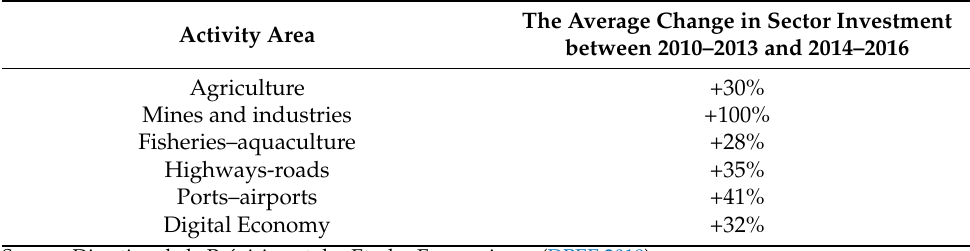
Table 1. Increase in sectoral public